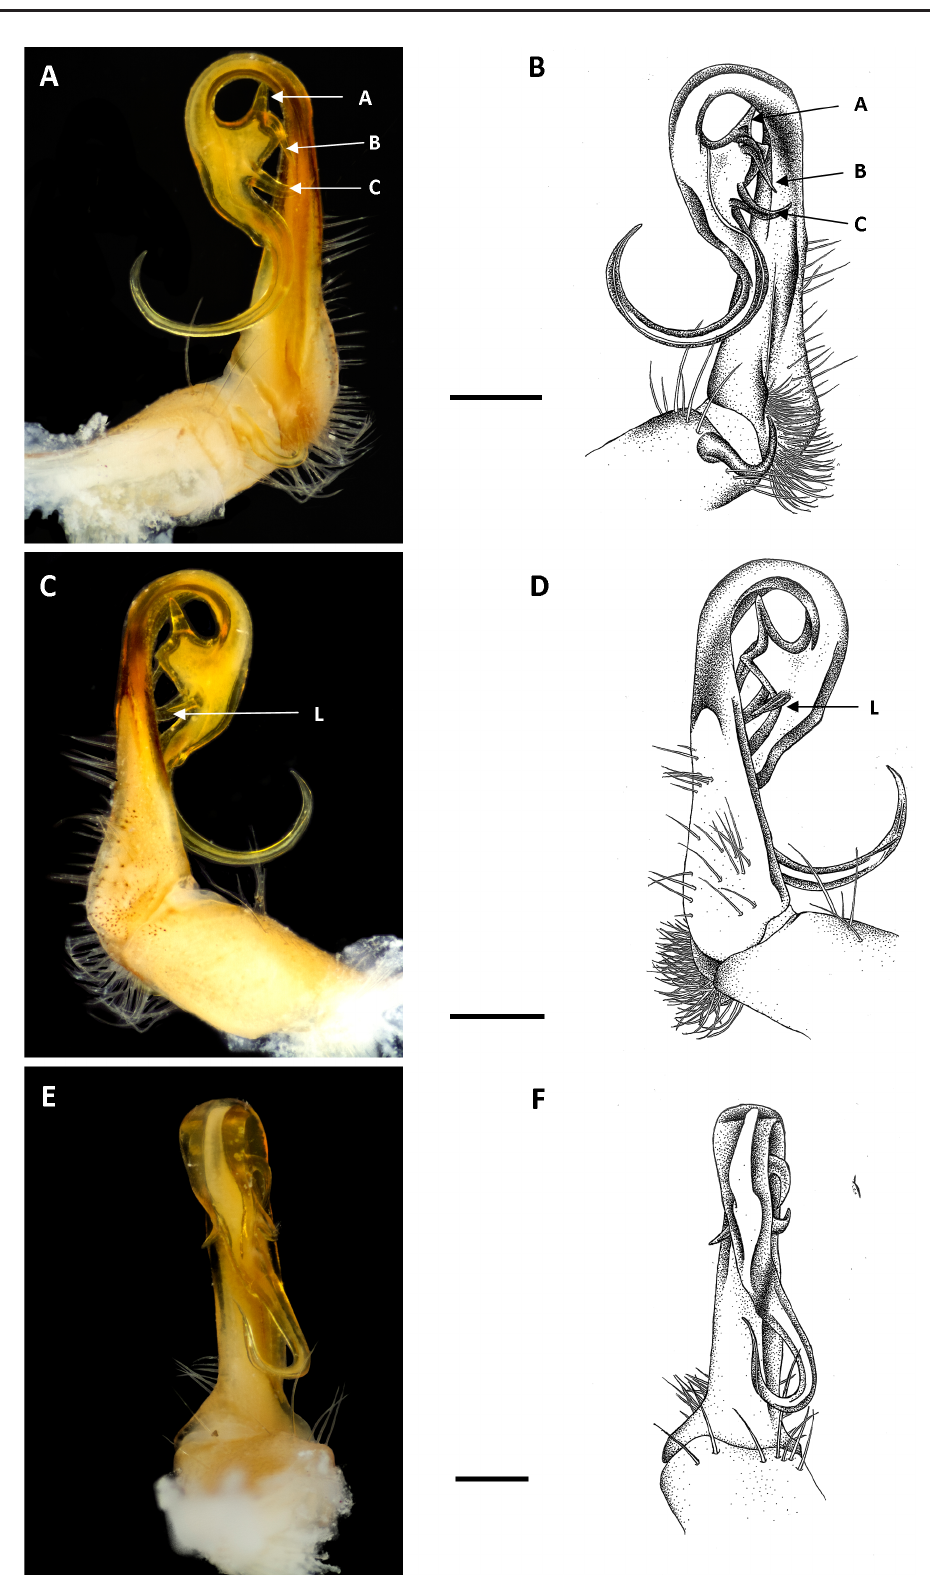
Fig. 18. Agrophogonus hamulifer Olsen & Enghoff sp. nov., holotype, ♂ (NHMD 621678), left gonopod. A–B . Mesal view. C–D . Lateral view. E–F . Dorsal view. Abbreviations: A = Process A; B = Process B; C = Process C; L = Process L. Scale bars: 0.5